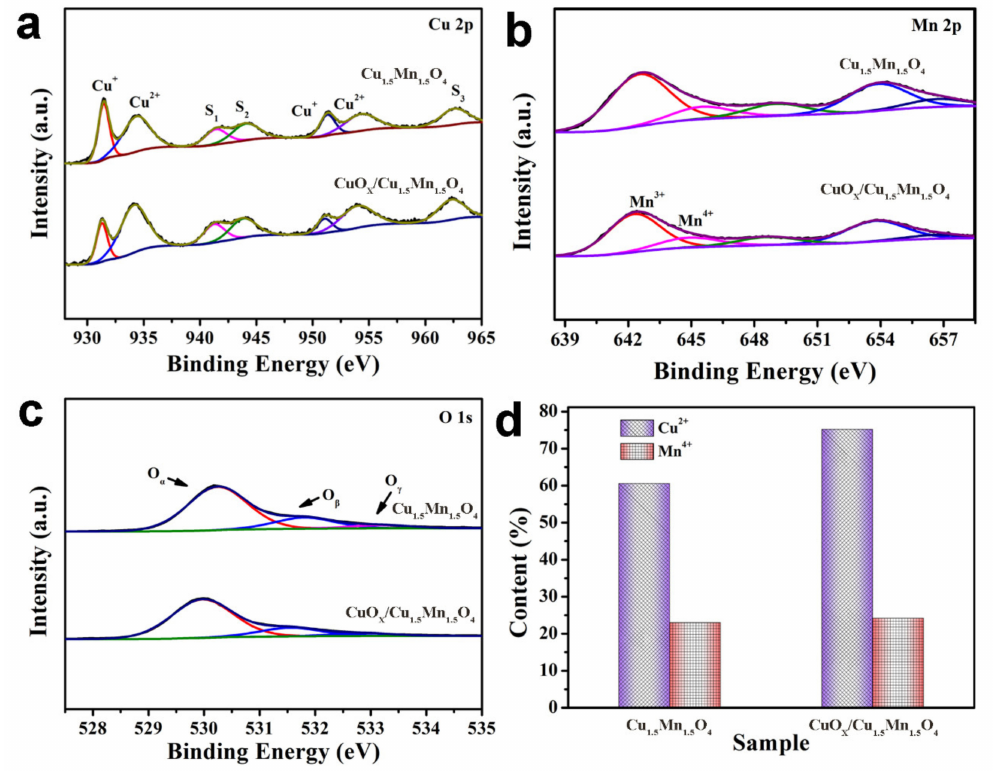
Figure 6. ( a ) Cu 2p; ( b ) Mn 2p; ( c ) O 1s spectra; ( d ) the contents of Cu 2+ and Mn 4+ in Cu 1.5 Mn 1.5 O 4 , and CuO x /Cu 1.5 Mn 1.5 O 4 ,